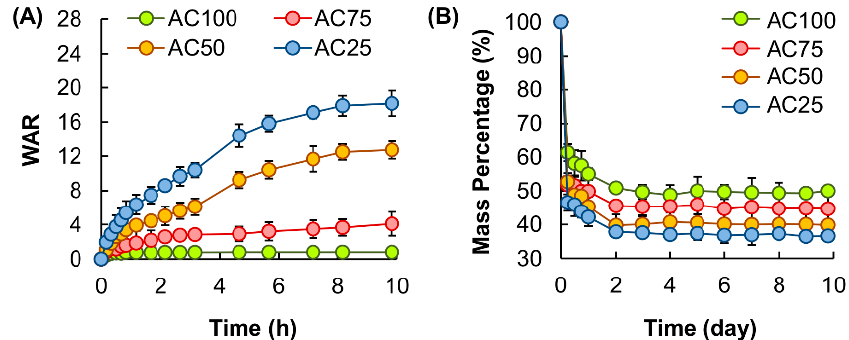
Figure 5. ( A ) The swelling capacity of complex gels with di ff erent mass percentages of CMC-Na in simulated body fluid. Data are presented as the means ± SD of triplicate experiments. ( B ) Susceptibility of complex gels with di ff erent mass percentages of CMC-Na to erosion in simulated body fluid. Data are presented as the means ± SD of triplicate experiments.